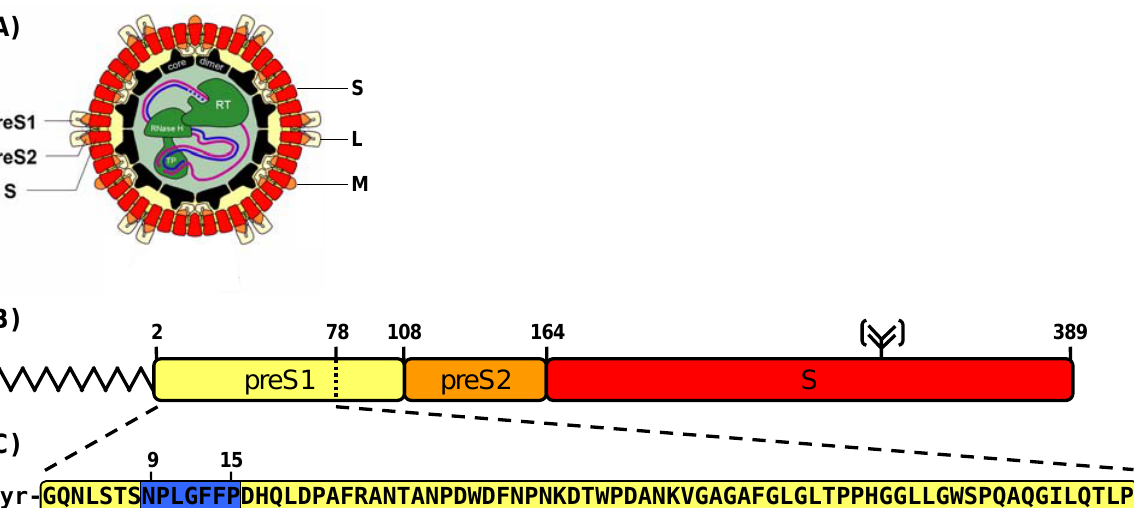
Figure 1. (a) The human hepatitis B virion. The partially double stranded DNA genome is encapsulated by an icosahedral shell and surrounded by three different surface proteins (L, M and S). (b) Domain structure of the large (L) HBV envelope protein. The L-protein consists of three subdomains, the preS1-domain (108 aa, yellow), the preS2-domain (55 aa, orange) and the S-domain (226 aa, red). The L-protein is N -terminally myristoylated at position 2 of the peptide sequence. Within the S-domain the protein bears a potential N - glycosylation site at Asn-309. (c) Acylated peptide sequence derived from the HBV L- protein that specifically inhibits a HBV infection in vitro and in vivo by blocking the virus entry. The myristoylated peptide corresponding to the N -terminal 77 aa of the preS1-part of the HBV L-protein is shown. The amino acids underlined in blue define the pharmacophore of the peptide sequence